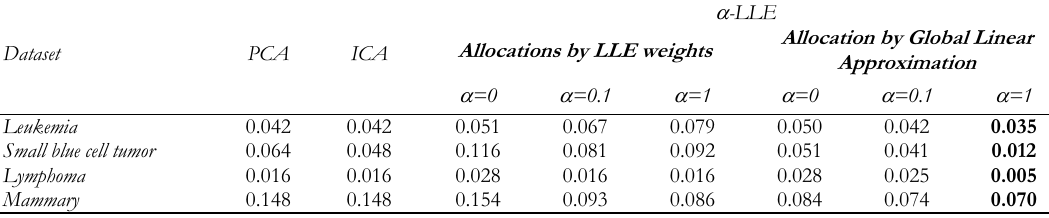
Cross validated misclassification rates of the best classifiers for each considered data set